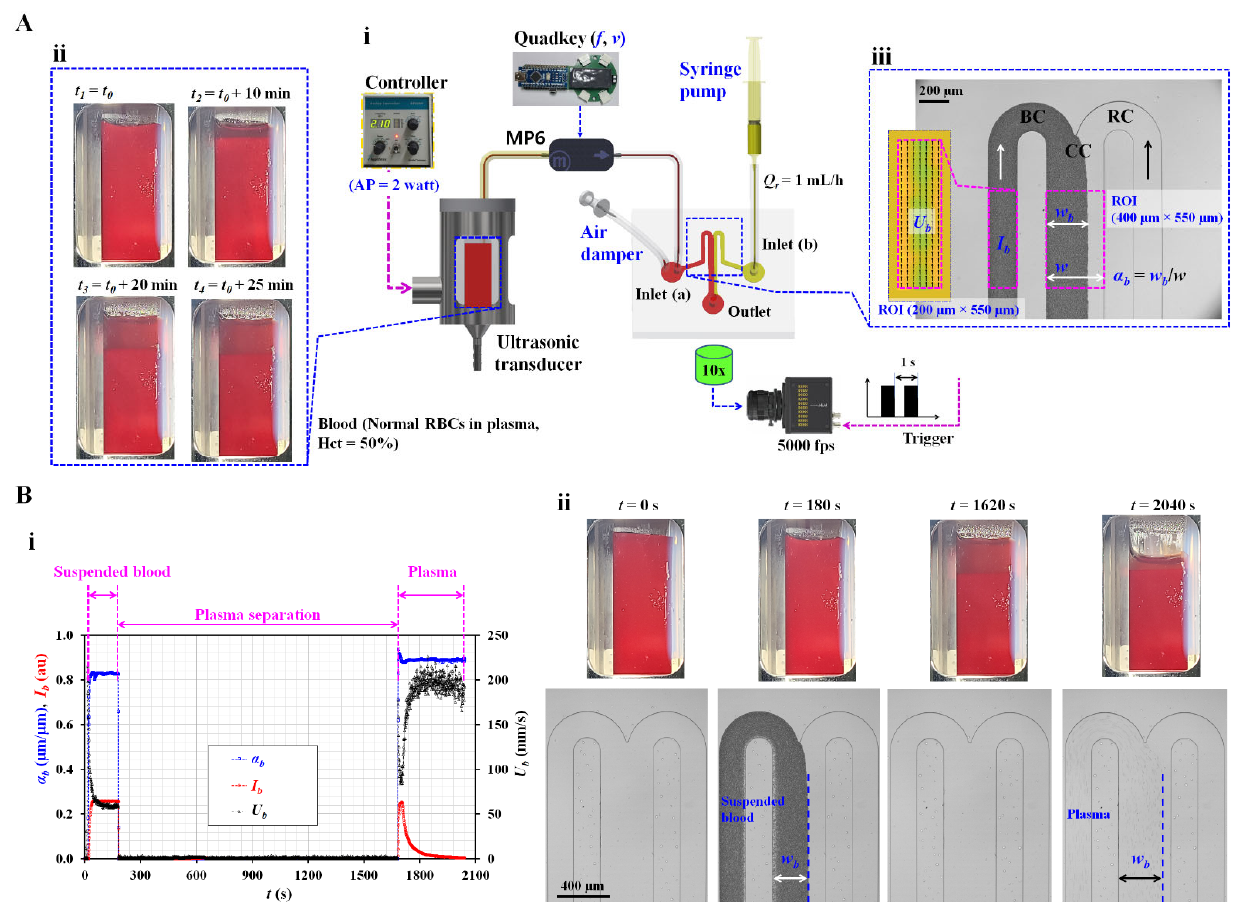
Figure 1. Proposed method for separating plasma and sequentially measuring individual viscosities of blood and plasma. ( A ) Experimental setup, plasma separation, and quantification of blood. (i) Schematic of the experimental setup, including, a microfluidic device, an ultrasonic transducer, two pumps (i.e., micro pump and syringe pump), and an image acquisition system. (ii) Plasma separation from the suspended blood with an elapse of time (i.e., t 1 = t 0 , t 2 = t 0 + 10 min, t 3 = t 0 + 10 t 4 = t 0 + 10 min). (iii) Quantification of blood velocity ( U b ) and interface ( α b ). ( B )